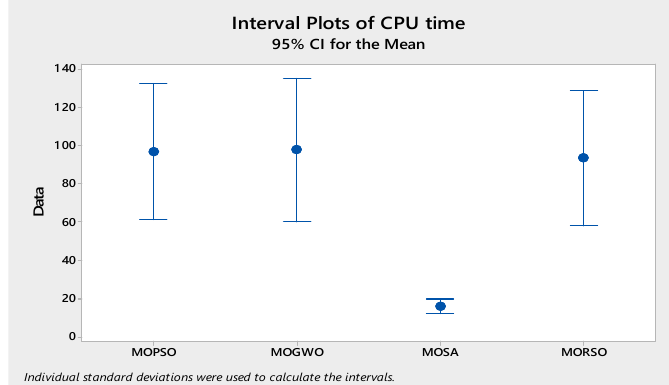
Individual standard deviations were used to calculate the intervals. Figure 19. Interval plots of CPU time.